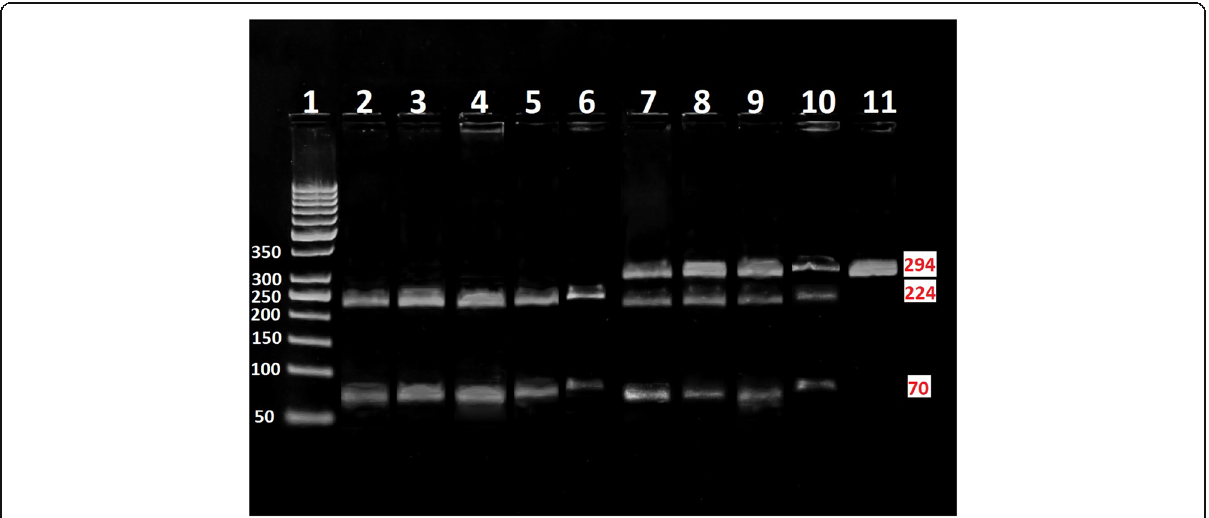
Fig. 2 Three percent agarose gel electrophoresis of SmlI restriction enzyme products. Lane 1 contains a 50 bp DNA ladder; lanes 2 – 6 show the genotype (A/A) represented by two bands of 224 bp and 70 bp; lanes 7 – 10 show the (A/-) genotype represented by three bands of 294 bp, 224 bp, and 70 bp; and lane 11 shows the (-/-) genotype represented by one band of 294